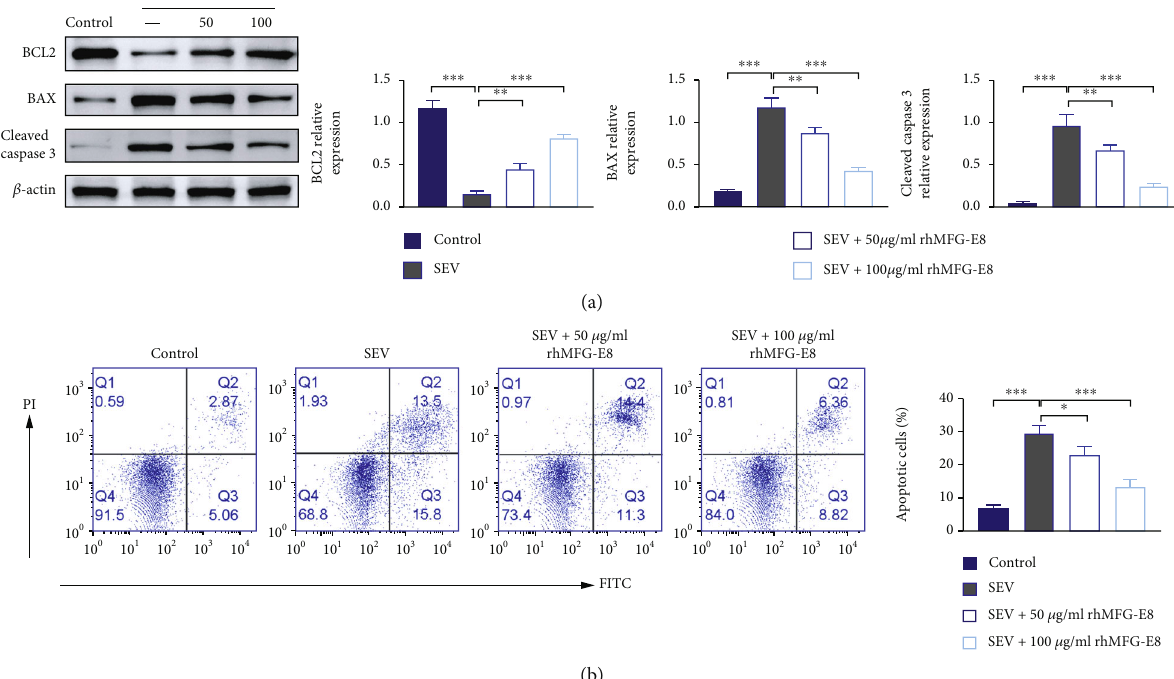
Figure 2: The apoptosis a ff ected by rhMFG-E8 on NSCs induced by SEV. (a) The protein (BCL2, BAX, and cleaved caspase-3) expression was a ff ected by sevo fl urane, sevo fl urane+50 μ g/ml rhMFG-E8 and sevo fl urane+100 μ g/ml rhMFG-E8. (b) The apoptosis rate was in fl uence by sevo fl urane, sevo fl urane+50 μ g/ml rhMFG-E8, and sevo fl urane+100 μ g/ml rhMFG-E8. ∗ p < 0 : 005 , ∗∗ p < 0 : 001 , ∗∗∗ p < 0 : 0001